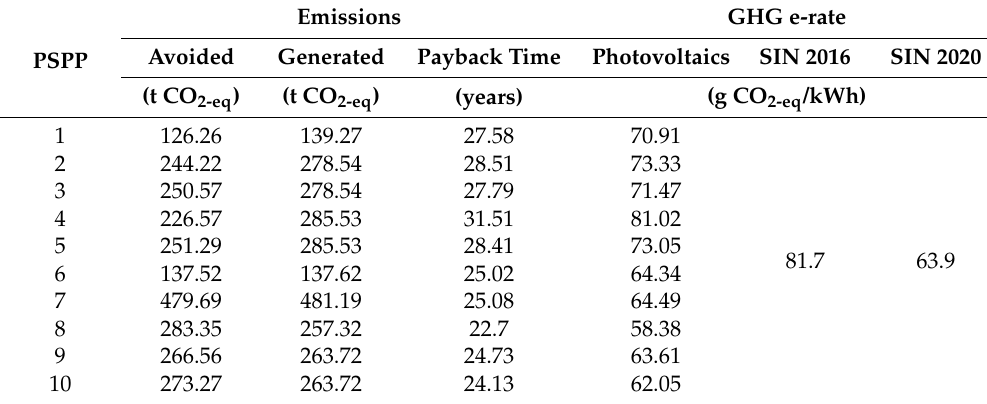
Table 8. Greenhouse gas emission rate (GHGe-rate) for the solar PV power plants. SIN—national interconnected system. Emissions GHG e-rate Avoided Generated Payback Time Photovoltaics SIN 2016 SIN 2020 PSPP (t CO 2-eq ) (t CO 2-eq ) (years) (g CO 2-eq